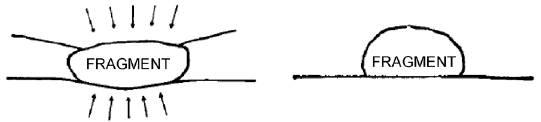
Fig. 2 Illustration of the formation of a “wear fragment” during contact and after losing contact